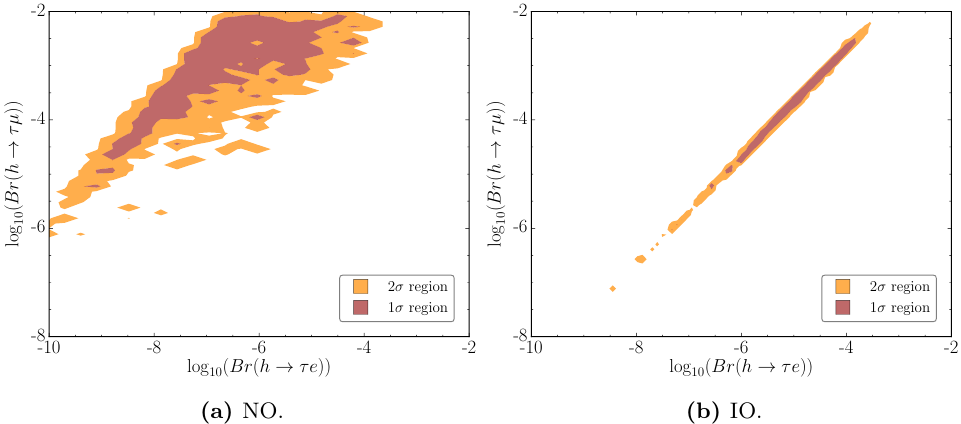
Figure 5. Allowed regions of the branching ratios Br( h (b) IO.